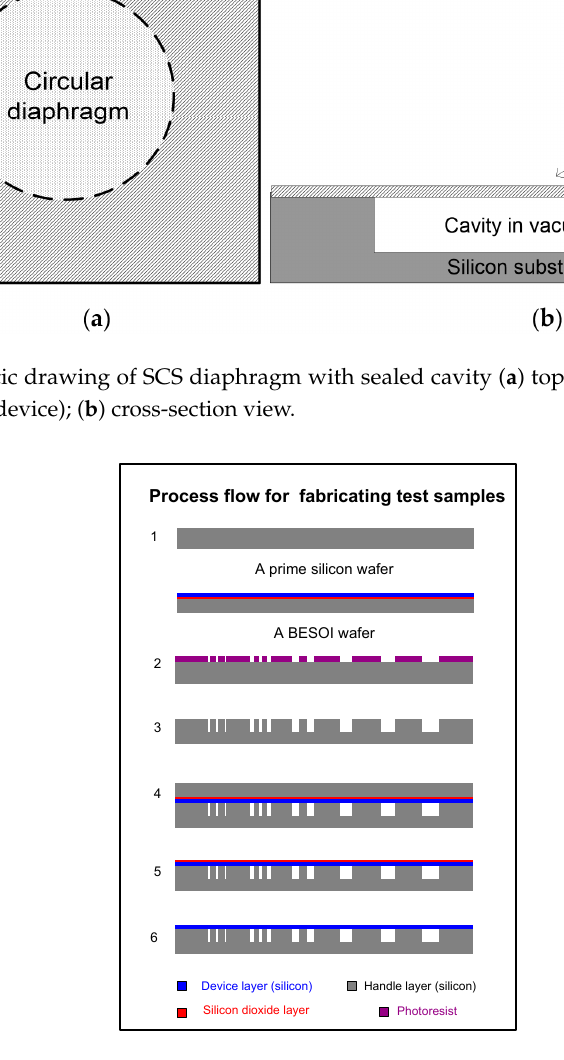
Figure 2. Process flow for fabricating SCS diaphragms with sealed cavity.